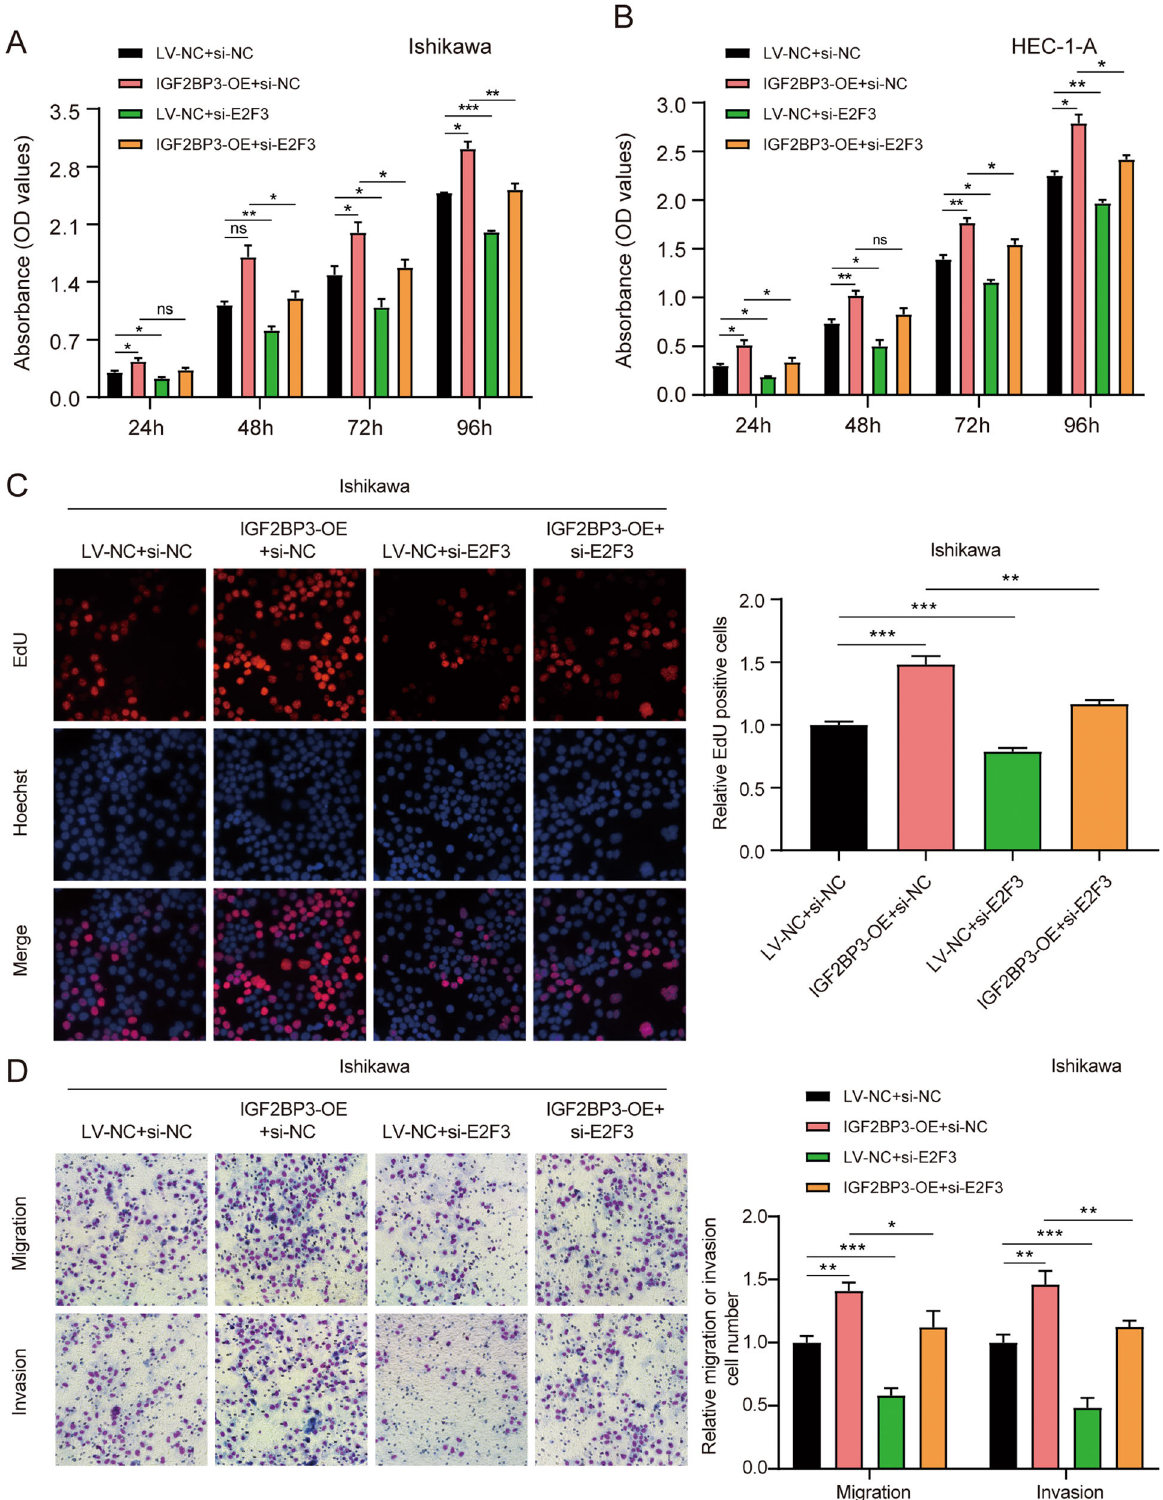
Fig. 6 IGF2BP3 exerted its tumor-promoting effects via E2F3 in EC. A and B CCK-8 assays showed the proliferation of Ishikawa cells and HEC-1-A cells overexpressing IGF2BP3 combined with E2F3-silenced expression. C EdU assays displayed the proliferation ability of Ishikawa cells overexpressing IGF2BP3 combined with E2F3-silenced expression. D Transwell assays indicated the migration and invasion of Ishikawa cells overexpressing IGF2BP3 combined with E2F3-silenced expression. On the right side of representative images are their quanti fi cation results. * P < 0.05, ** P < 0.01, *** P < 0.001, “ ns ” , no statistical signi fi cance. Data, mean ± S.D. All experiments were independently repeated with at least three